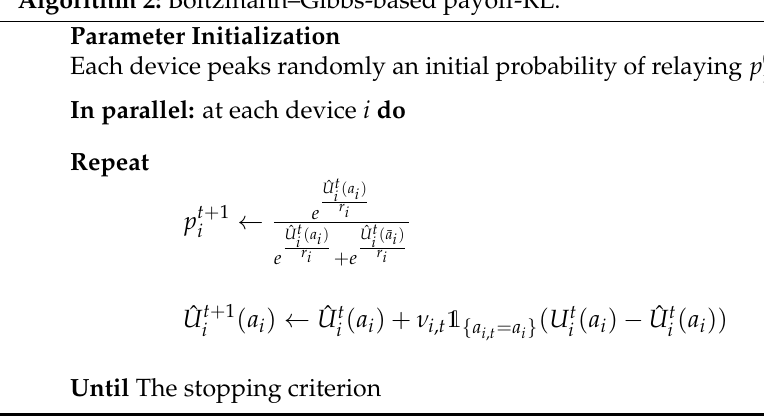
Algorithm 2: Boltzmann–Gibbs-based